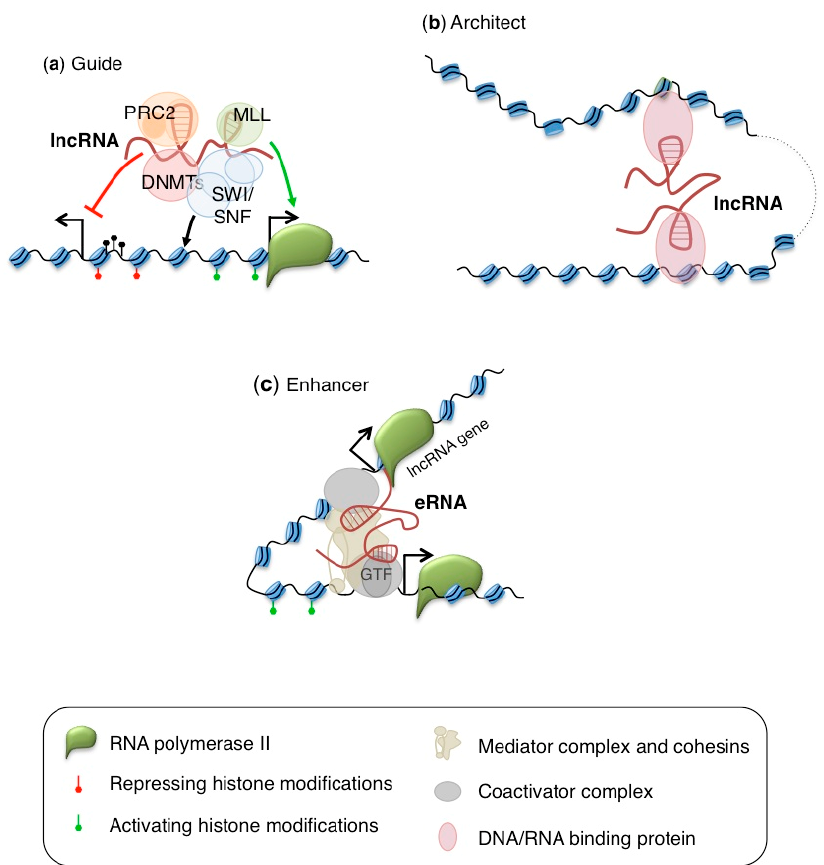
Figure 1. Nuclear lncRNAs may act as: ( a ) guide lncRNAs, which act by recruiting or rejecting epigenetic regulators (chromatin modifying complexes and chromatin remodeling complexes) onto specific chromosomal loci; ( b ) architect lncRNAs, which act by modifying the three dimensional conformation of chromatin; and ( c ) enhancer lncRNAs (also called eRNAs), which regulate transcription through enhancer-like functions.